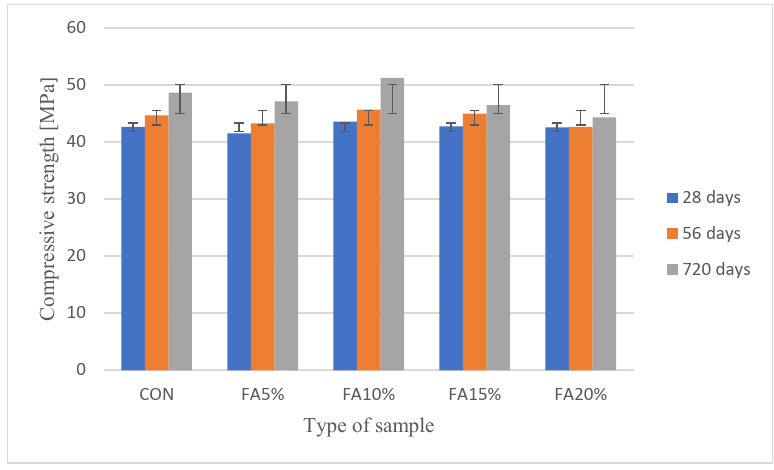
Figure 8. Compressive strength after 28, 56 and 720 days of